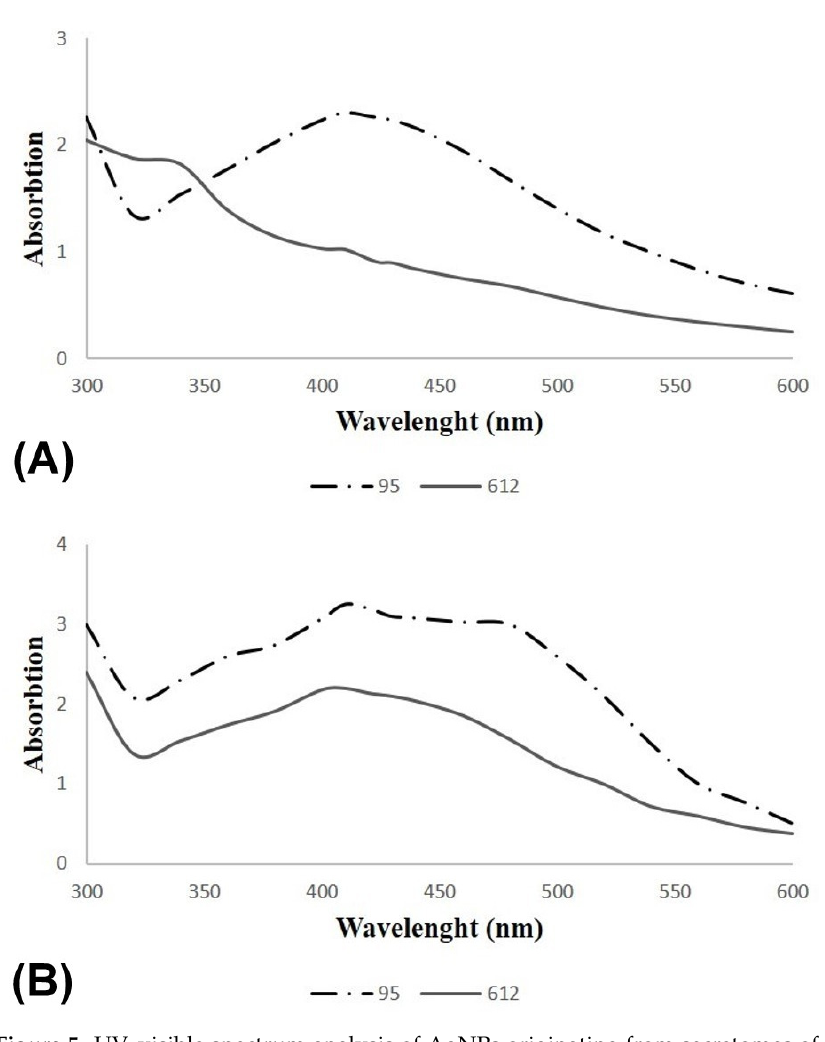
Figure 5. UV–visible spectrum analysis of AgNPs originating from secretomes of Geobacillus spp. 95 and 612 treated with 2 mM AgNO 3 after 24 h incubation ( A ) and 48 h incubation ( B ) at 55 °C.